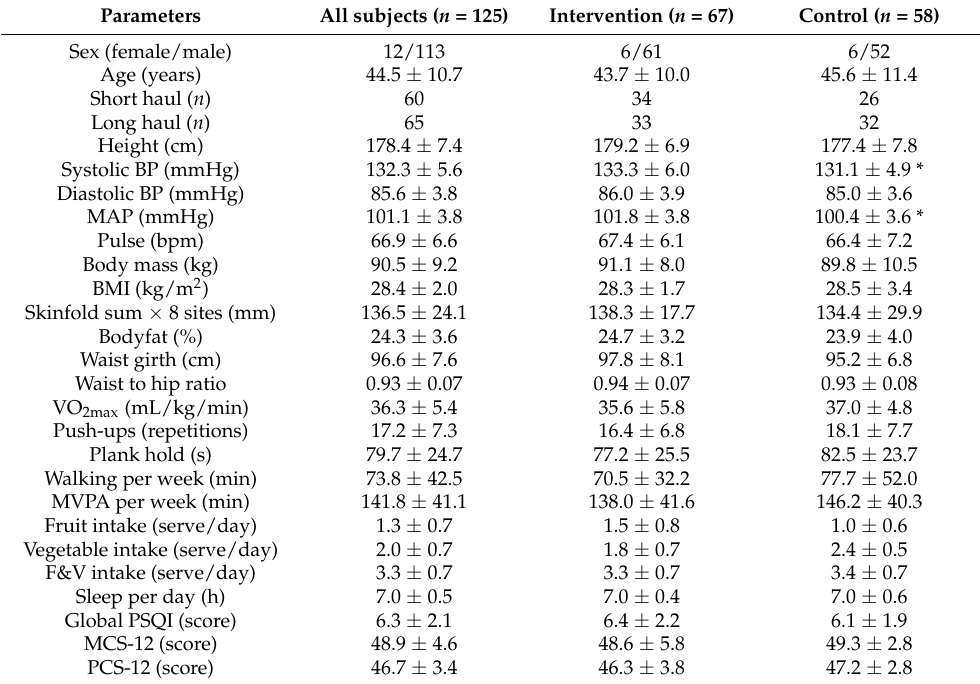
Table 1. Baseline characteristics of